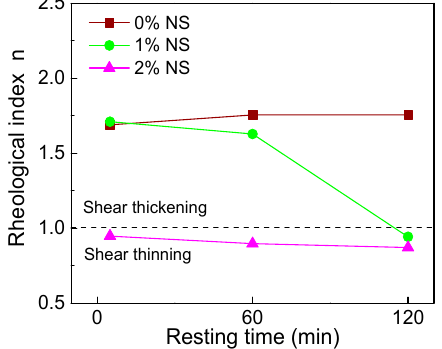
Figure 13. Influence of resting time on n.